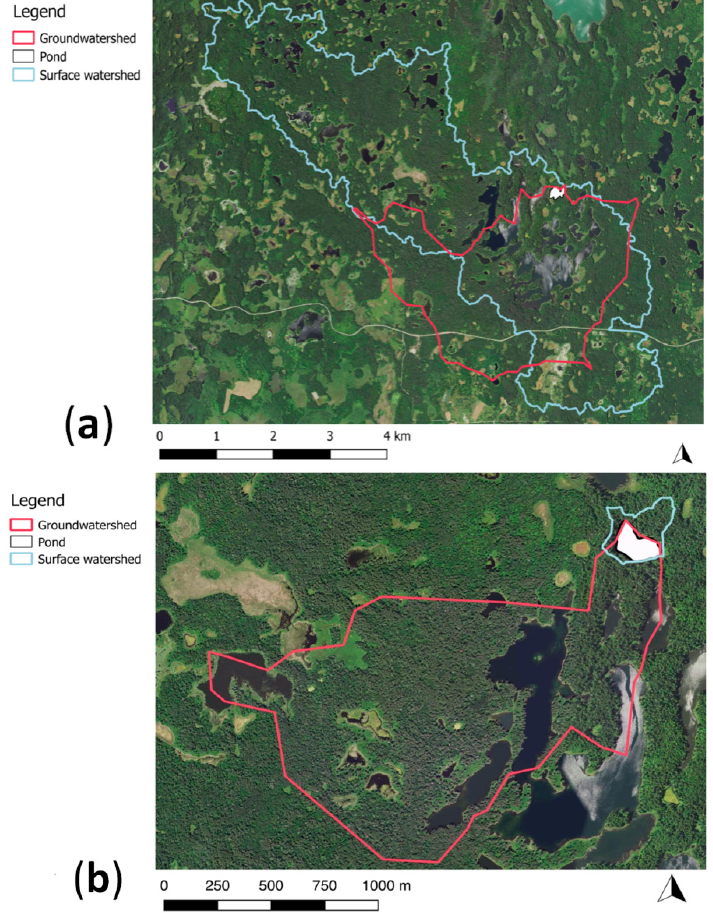
Figure 12. ( a ) Surface watershed and groundwatershed delineated for an unnamed pond near Little Elk Lake. This pond has a calculated surface watershed and groundwatershed area ratio (SW:GW) = 2.17. ( b ) Surface watershed and groundwatershed delineated for an unnamed pond near Whipple Lake. This pond has a SW:GW =